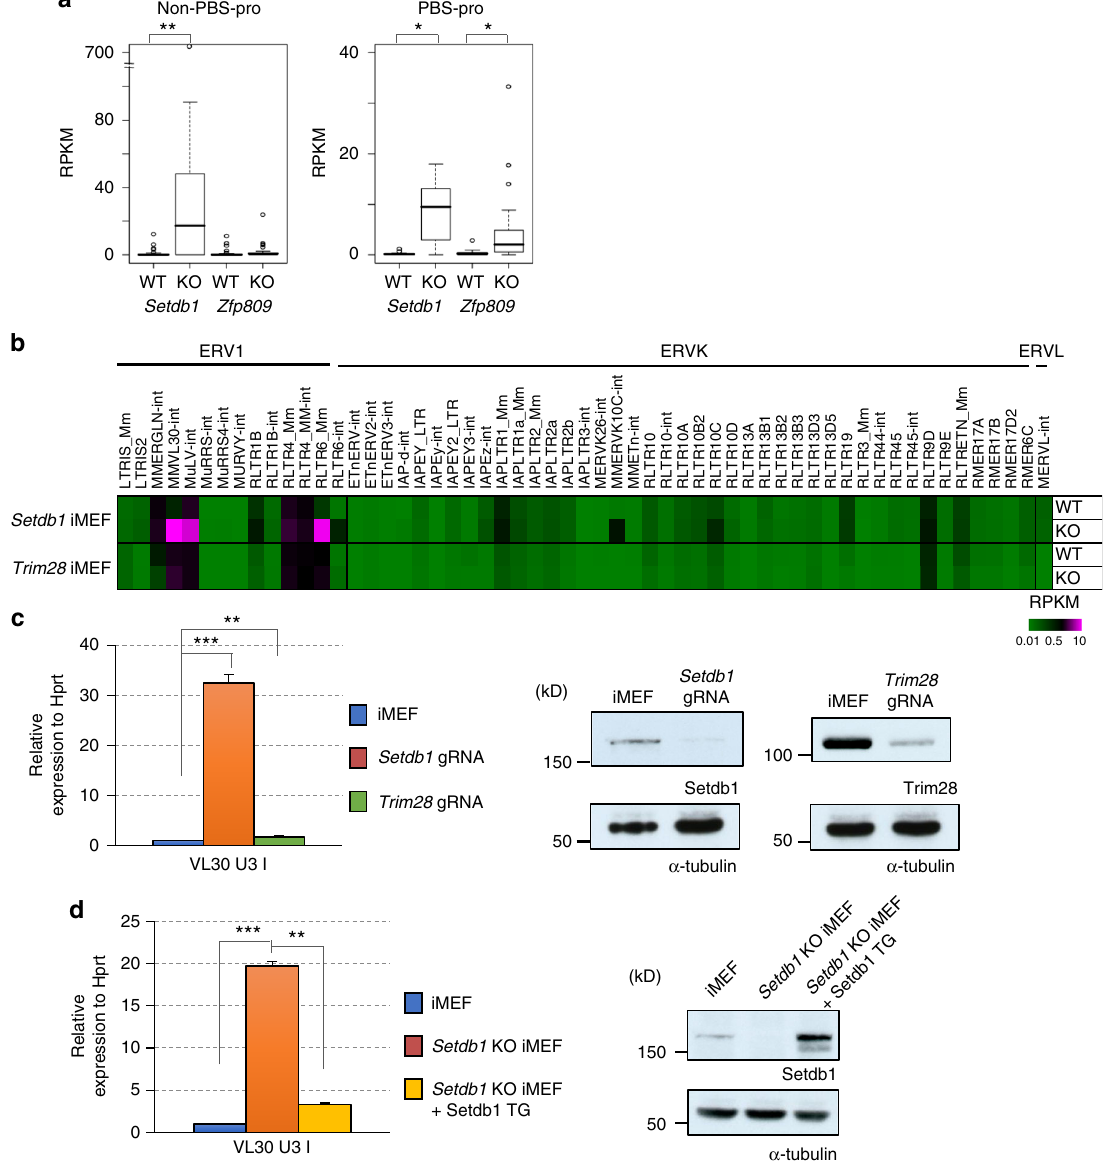
Fig. 5 Distinct requirement of Setdb1, Trim28, and Zfp809 for VL30 silencing. a Boxplots indicate silencing effects on VL30 U3 I by Setdb1 and Zfp809. 71 VL30 U3 I (MMVL30-int with RLTR6_Mm U3 I) are divided into two groups according to with (22 loci) or without (49 loci) PBS-pro sequences. RNA-seq data of Setdb1 cKO iMEFs (no treatment (WT) or 4OHT 5d (KO)), Zfp809 KO MEFs derived from mutant embryos (KO) and wild type (WT) 38 are shown. was reanalyzed. Heatmap indicates the magnitude of the RPKM value. For comparison, Setdb1 cKO iMEF data (Fig. 1a) was shown above. c Trim28 KO only marginally lead to VL30 derepression. iMEFs were transfected with a CRISPR-gRNA vector against Setdb1 or Trim28 . Two days later, transfected cells (tRFP-positive) were sorted using FACS Aria. Four days later, cells were harvested, and RT-qPCR of VL30 U3 class I was performed. ( Trim28 ; n = 3 biological replicates Setdb1 ; n = 3 technical replicates) Error bars represent s.d. **0.0005< P < 0.005, *** P < 0.0005, Student ’ s t -test. Ef fi ciencies of CRISPR KO were examined by immunoblotting with anti-Setdb1 or anti-Trim28 antibodies. d Reintroduced Setdb1 represses VL30 in Setdb1 KO iMEFs. Setdb1 was stably expressed in Setdb1 long-term-cultured KO iMEFs. RT-qPCR of VL30 U3 class I was performed. ( n = 2 biological replicates). Error bars represent s.d. **0.0005 < P < 0.005, *** P < 0.0005, Student ’ s t -test. Expression level of Setdb1 was examined by